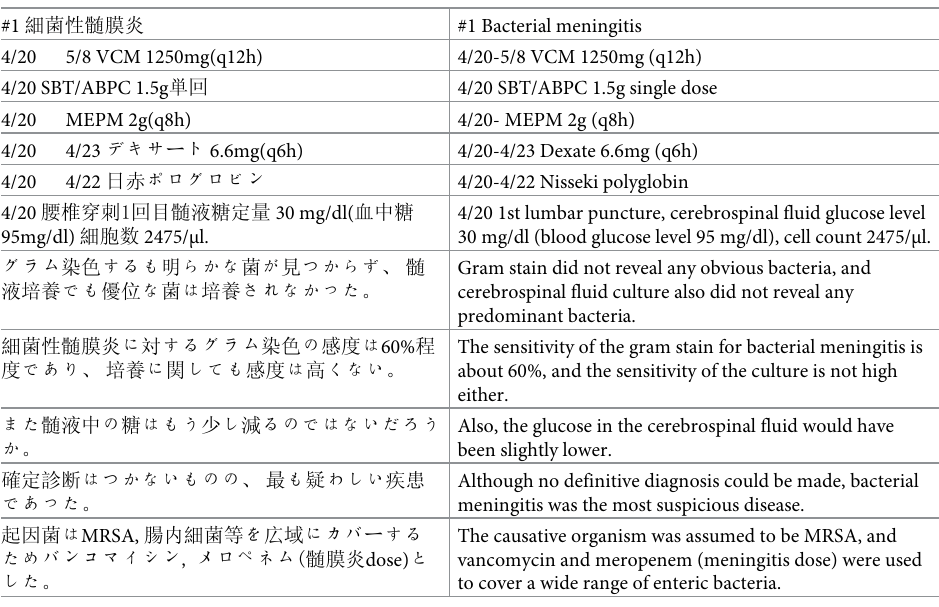
Table 4. Example of a discharge summary.